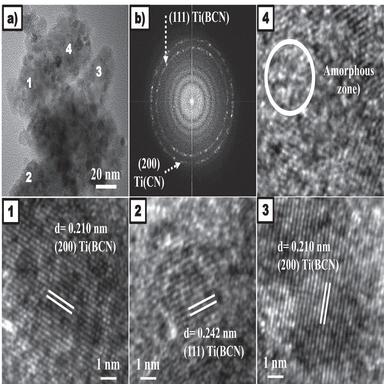
a) High-resolution TEM (HRTEM) image for 300TiBCN showing the presence of Ti(BCN) that is unique to this sample. b) Fast Fourier Transform (FFT) image obtained from the 300TiBCN HRTEM image. Numbers 1, 2 and 3 (marked also in a) correspond to crystallographic planes detected for the Ti(BCN) phase. Number 4 correspond to an amorphous zone detected between nanocrystals with different orientations.